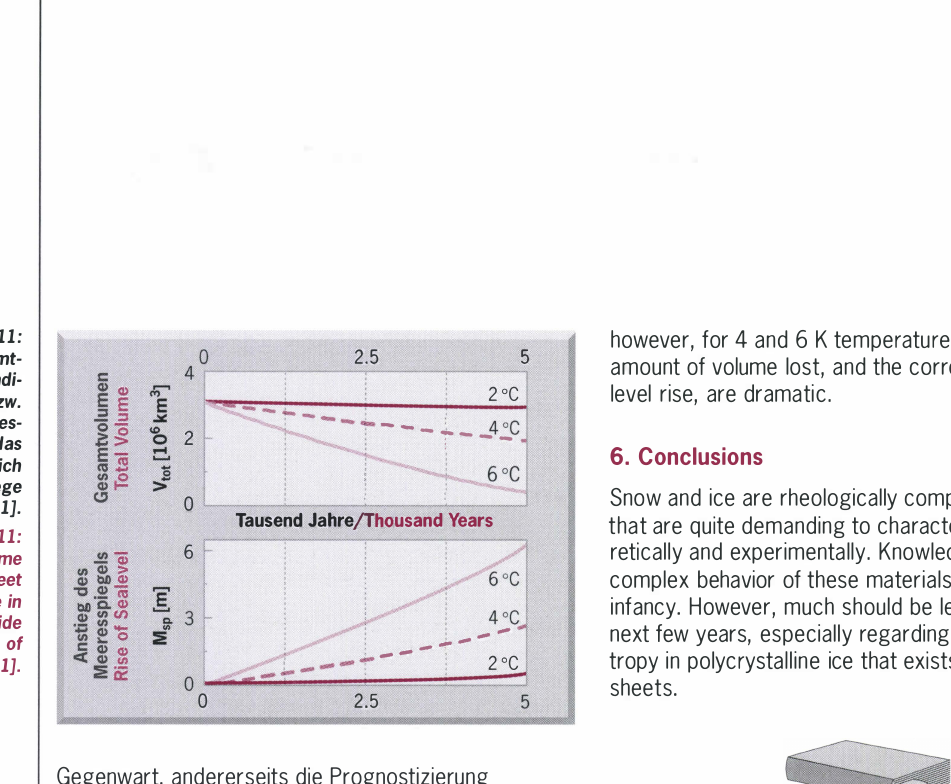
Fig.ll: Decrease in the total volume of the Greenland ice sheet and the corresponding rise in sea level due to a worldwide rise in mean temperature of 2, 4, and 6•K